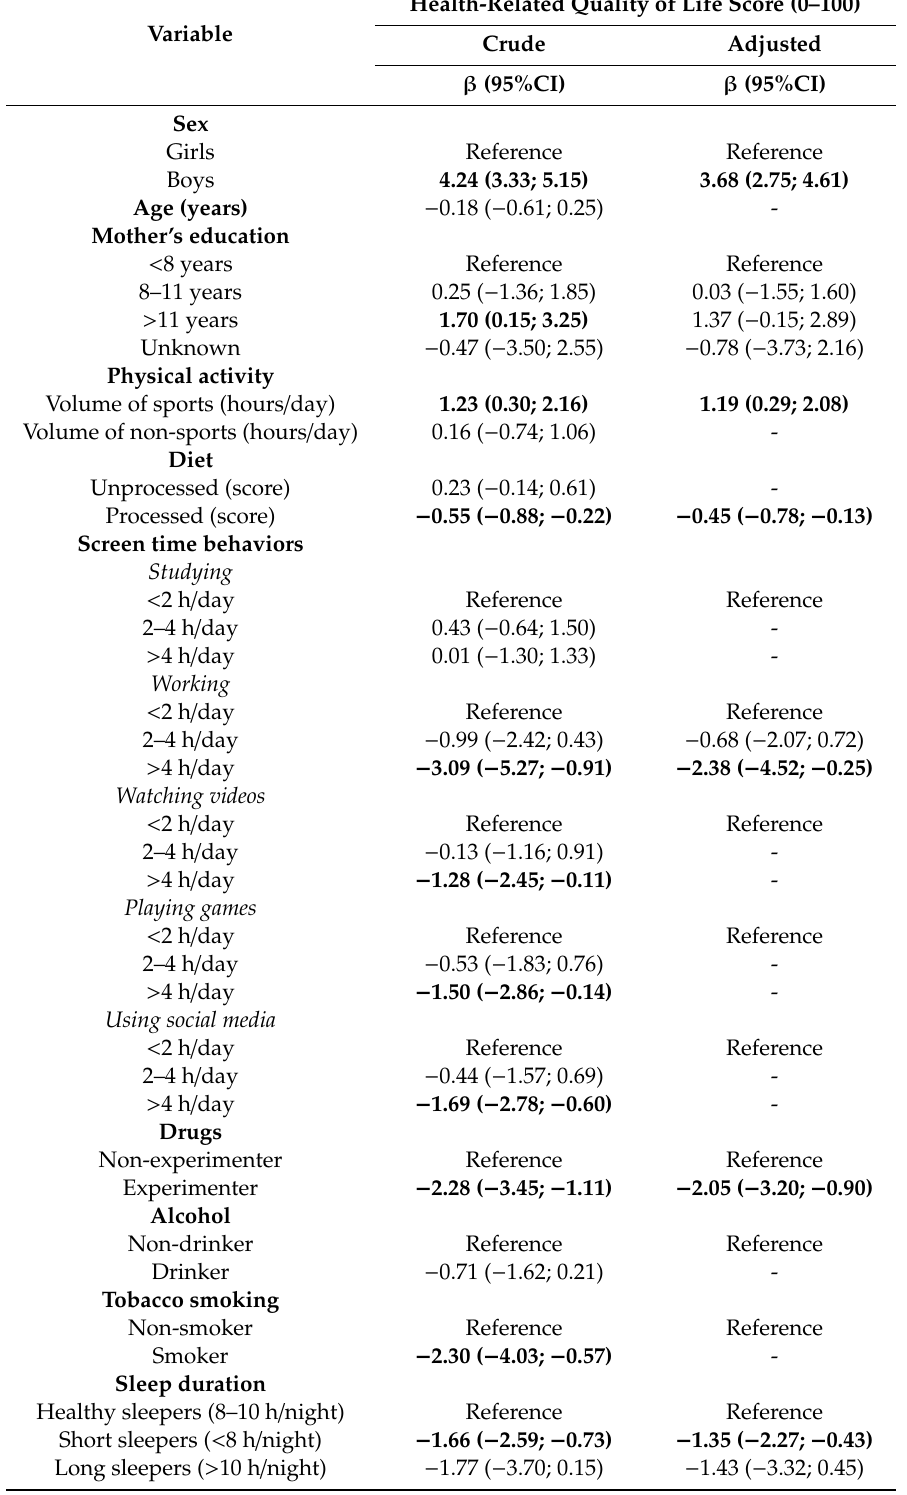
Table 2. Association between lifestyle indicators and health-related quality of life in a sample of Brazilian adolescents ( n = 739),